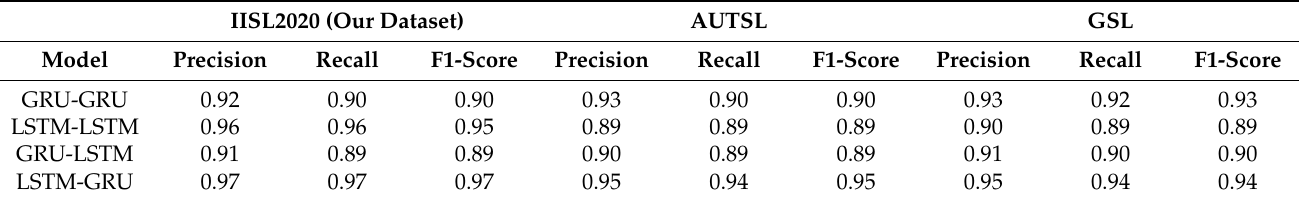
Table 2. Experimental results, with the various parameters.